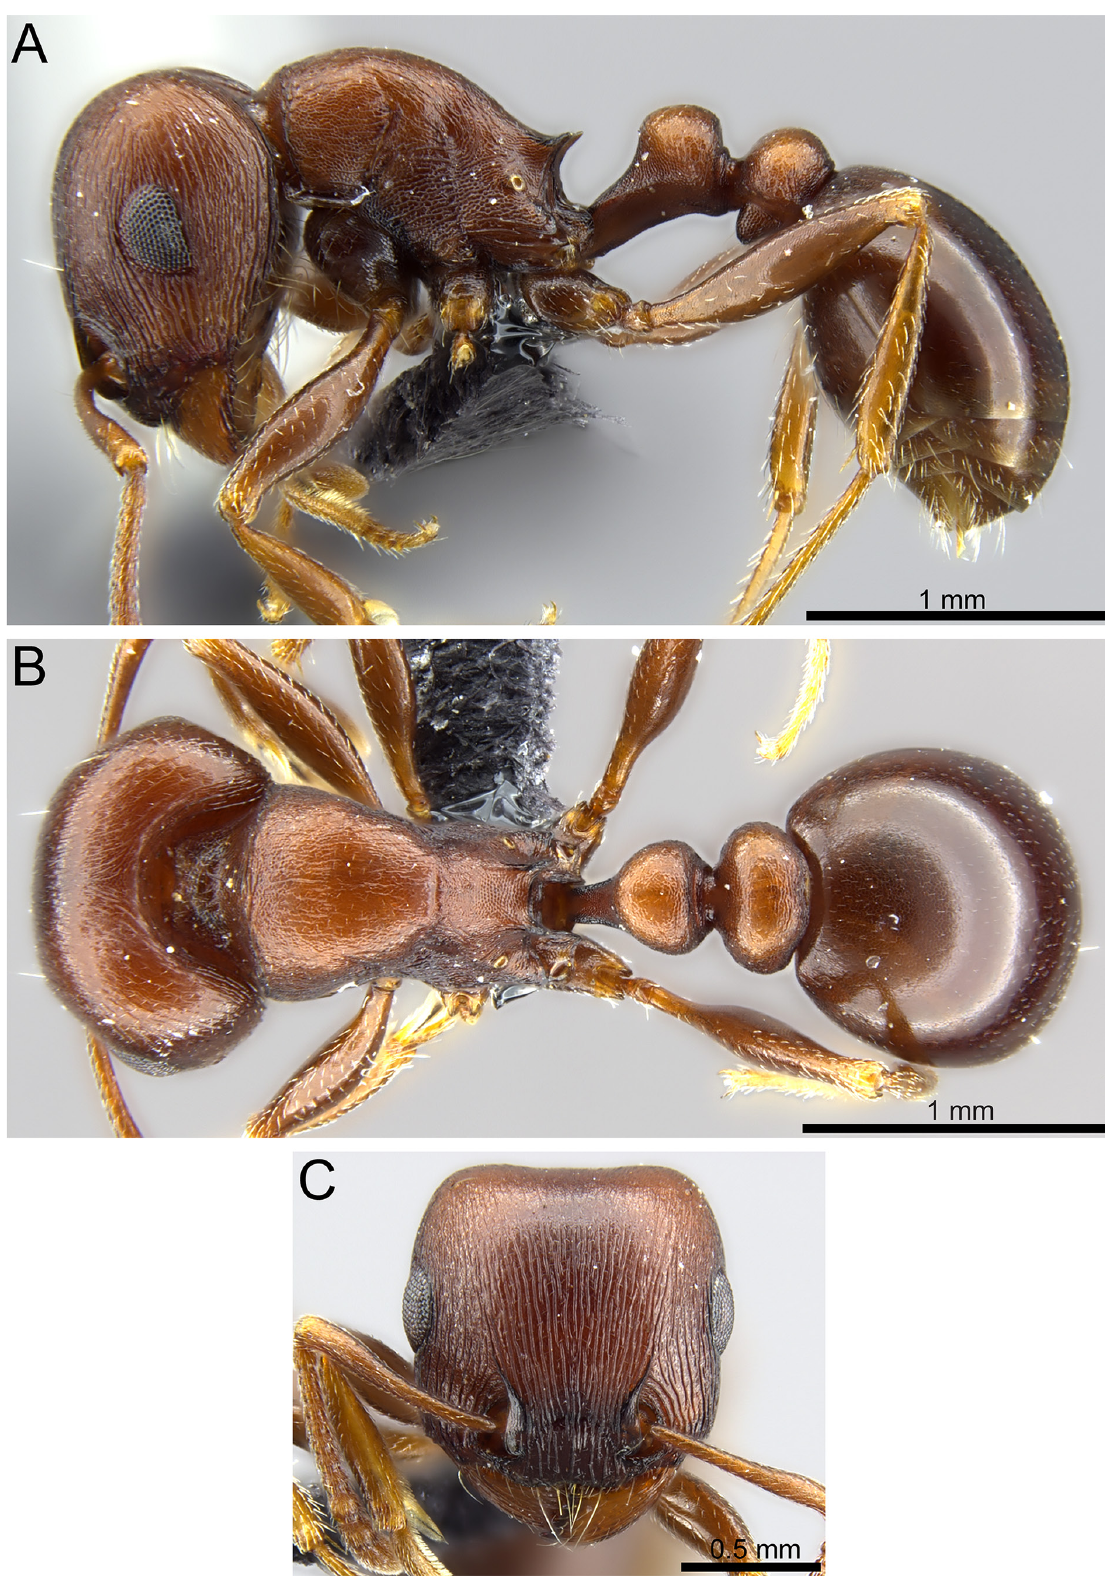
Fig. 12. Tetramorium glabratum Stitz, 1923 (SAM-HYM-C024395). A . Body in profile. B . Body in dorsal view. C . Head in full-face